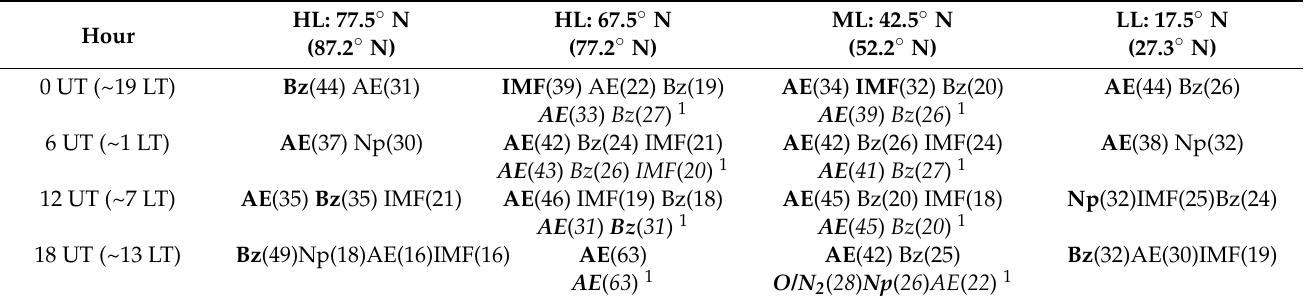
Table 5. The same as in Table 3 but for 21–31 March